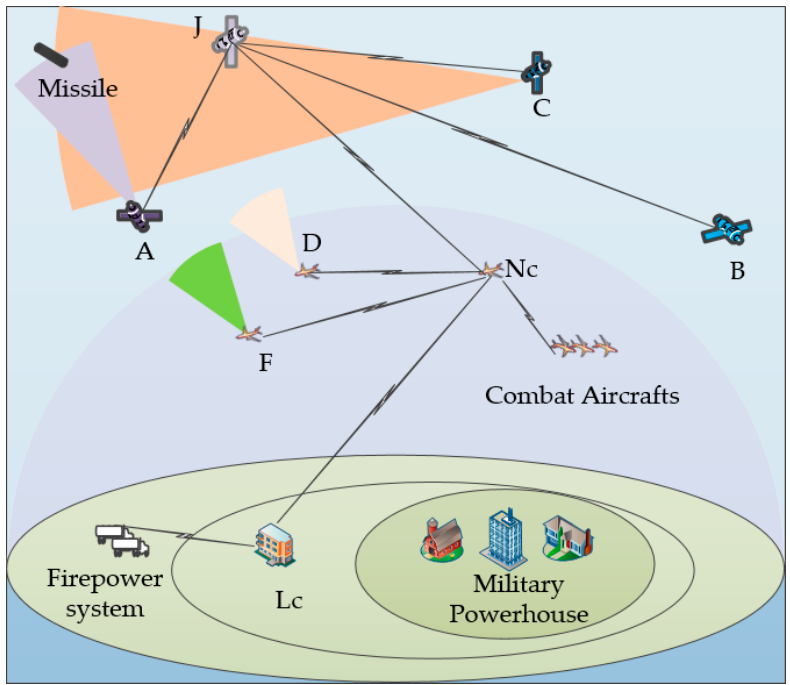
Figure 8. R-SIN advanced operational model supporting anti-missile tasks.